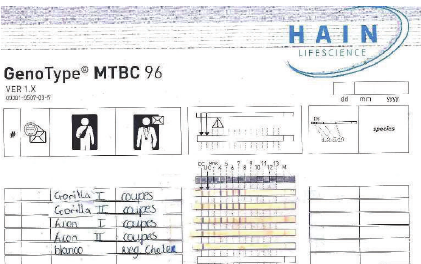
Figure 2: Emaciated lioness.